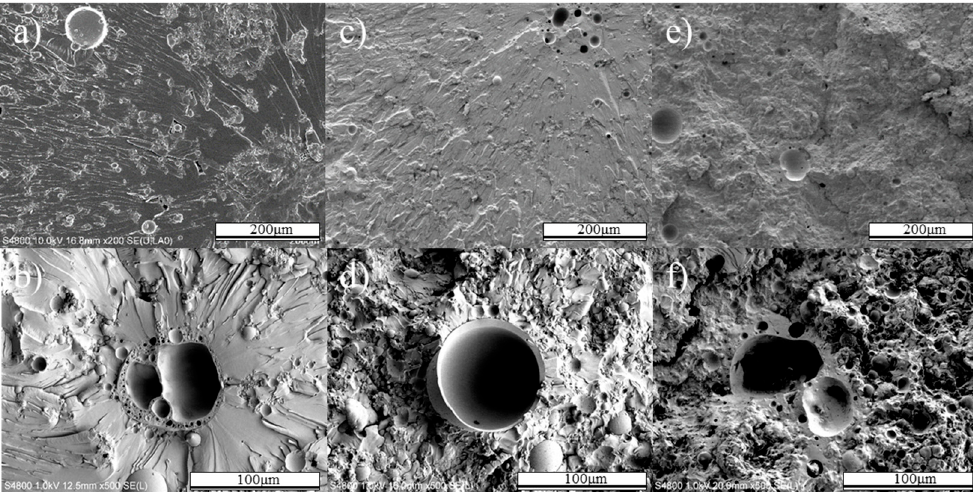
Figure 8. Fracture surface of less than 90 µ m fly ash / epoxy composite in the direction of tensile loading. 10 vol.% fly ash / epoxy composite (( a ) low magnification, ( b ) high magnification), 30 vol.% fly ash / epoxy composite (( c ) low magnification, ( d ) high magnification), 50 vol.% fly ash / epoxy composite (( e ) low magnification, ( f ) high magnification.) .